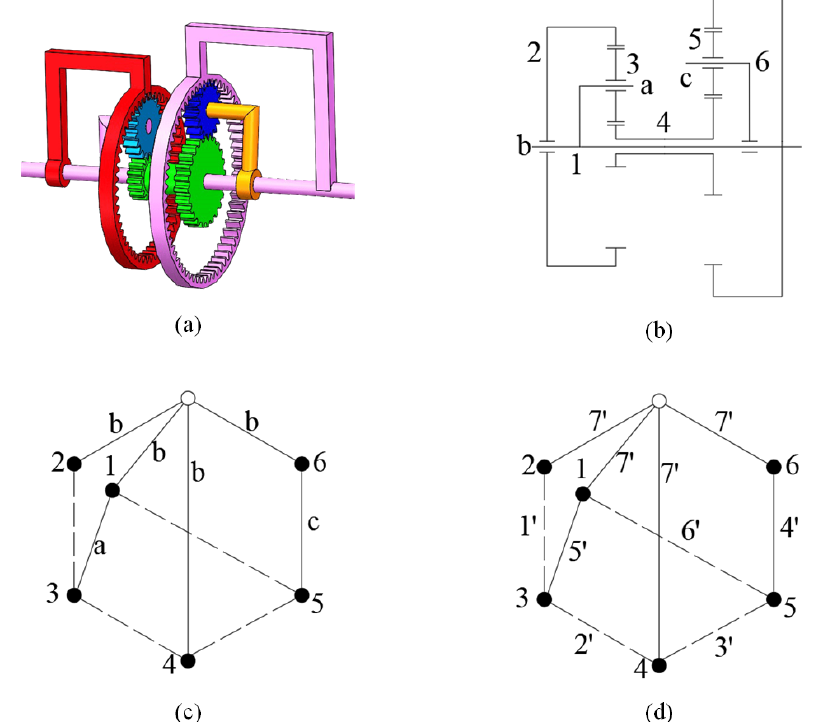
Figure 1. Topological description of the EGT.